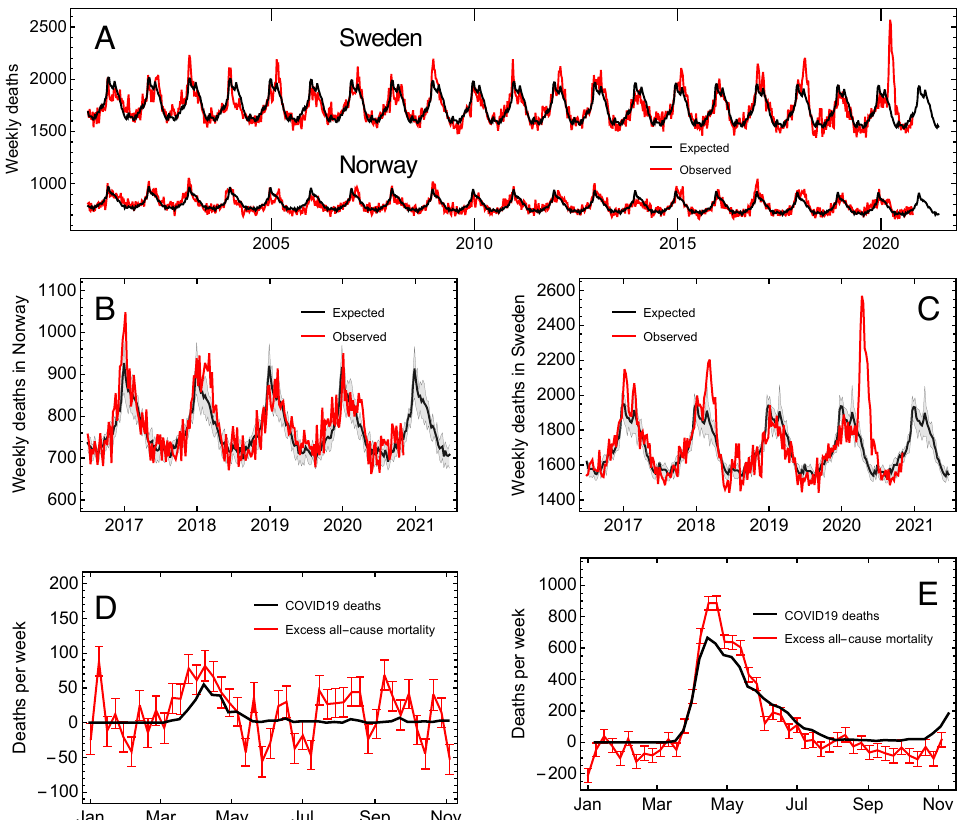
Figure 1. Expected and observed mortality. ( A ) The weekly deaths in Norway and Sweden (red) together with the estimated baseline (black). ( B ) Same as for Norway in ( A ), but for the years 2016/17 to 2020/21. The gray region shows the interquartile range for the seasonal variation. ( C ) As ( B ), but for Sweden. ( D ) The excess weekly mortality in Norway (red) and COVD-19-related deaths (black). The error bars is the 95% CI for the excess mortality based on the Monte–Carlo simulation for the estimate of the baseline. ( E ) As ( D ), but for